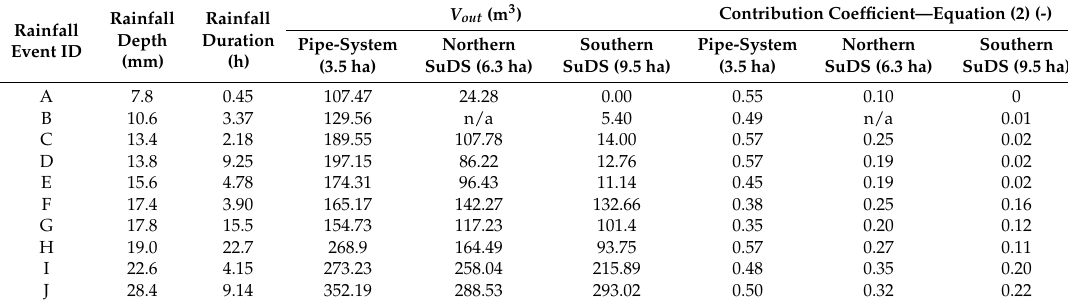
Table 2. Calculated REIAs and their corresponding contribution coefficients for 10 rain events. Rainfall Event